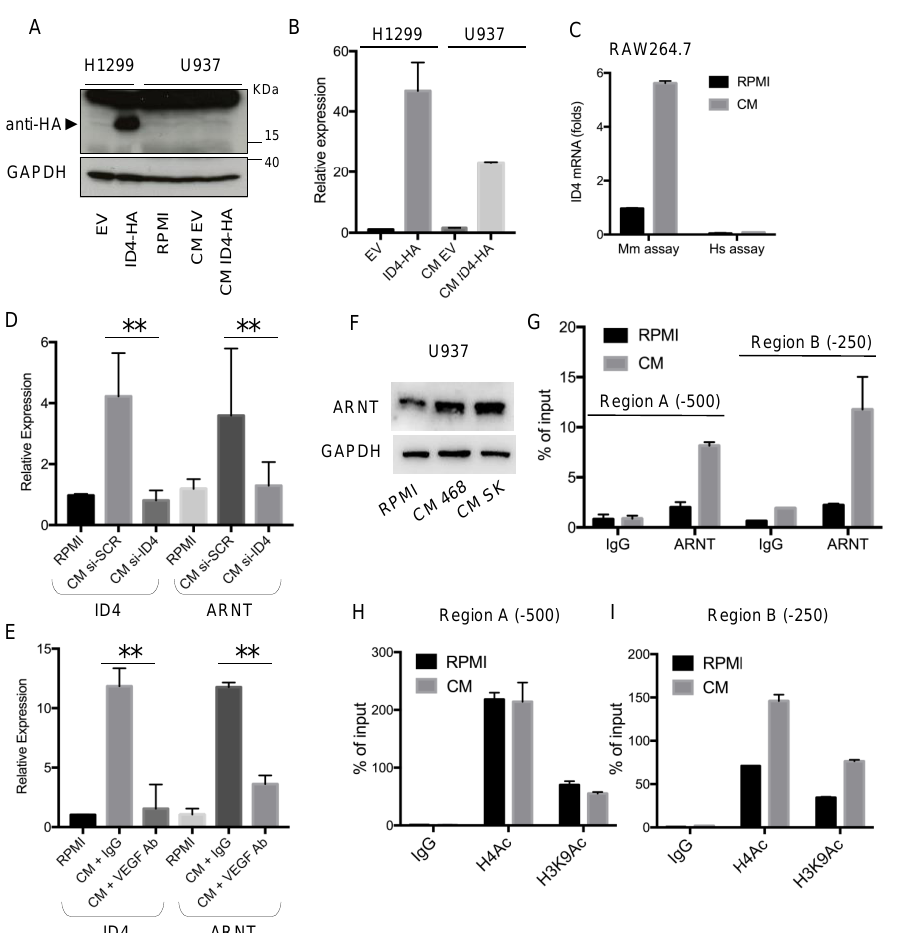
Figure 3. ( A , B ) ID4 expression analyzed by Western blot ( A ) and RT-qPCR ( B ) in recipient H1299 cells, transfected with an empty vector (EV) or an HA-tagged ID4 expression vector, and in U937 cells cultured with RPMI, CM from H1299-EV or CM from H1299-ID4-HA cells. ( C ) ID4 mRNA expression in RAW264.7 mouse macrophages grown with RPMI medium or with CM from human breast cancer cells evaluated with primers recognizing the mouse (Mm assay) or human (Hs assay) ID4 cDNA sequence. ( D ) ID4 and ARNT mRNA expression evaluated by RT-qPCR in di ff erentiated U937-derived macrophages cultured with RPMI or with conditioned medium (CM) from control (si-SCR) or ID4-depleted (si-ID4) MDA-MB-468 breast cancer cells for 48 h. Data were normalized with respect to GAPDH expression. p -values were calculated on the fold decrease between si-SCR and si-ID4 conditions. ( E ) ID4 and ARNT mRNA expression evaluated by RT-qPCR in di ff erentiated U937-derived macrophages cultured with RPMI or with conditioned medium (CM) from MDA-MB-468 breast cancer cells in the presence of the control antibody (IgG) or VEGFA blocking antibody (VEGFA Ab) for 48h. Data were normalized with respect to GAPDH expression. p -values were calculated on the fold decrease between IgG and VEGF Ab conditions. (F) ARNT protein expression evaluated by Western blot in di ff erentiated U937 cells cultured with RPMI or with CM from MDA-MB-468 (CM 468) or SKBR3 (CM SK) for 24h. ( G – I ) Chromatin immunoprecipitation analysis of di ff erentiated U937 cells cultured with RPMI or with conditioned medium (CM) from MDA-MB-468 breast cancer cells for 24h. IP was performed with anti-ARNT ( G ) or anti-acetylated histone H4 or anti-acetylated histone H3K9 ( H , I ). Two regions of the ID4 promoter located nearly at − 500 (region A) and − 250 (region B) bp from TSS were analysed. ** ( p < 0.005). P-values were calculated by a paired two-tailed t-test.